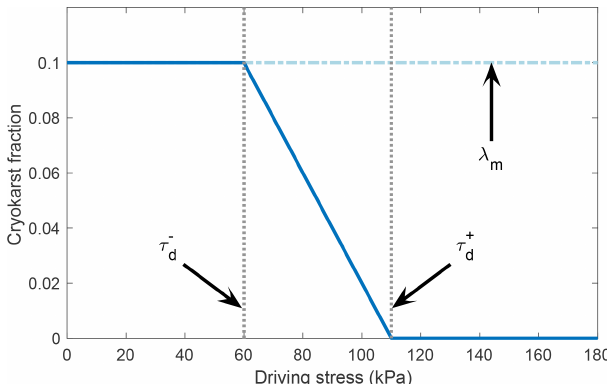
Figure 1. Cryokarst area fraction λ for a range of driving stress values τ d for the case of τ −